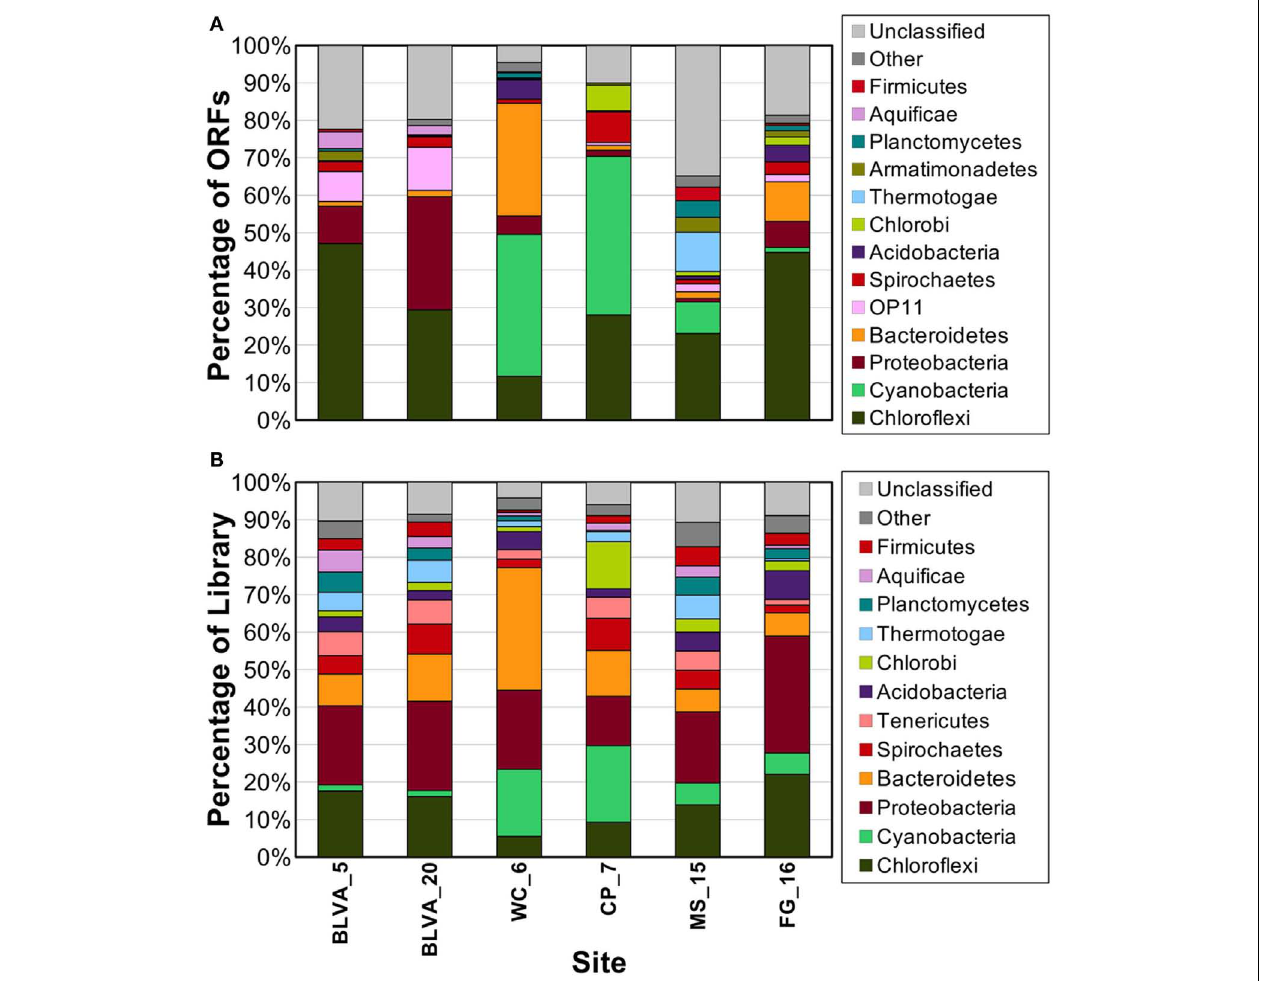
AMPHORA, and compared to (B) 16S rRNA sequences from ribosomal panels ( n ∼ 300 per site) classified at the phylum-level against the RDP at a confidence threshold of